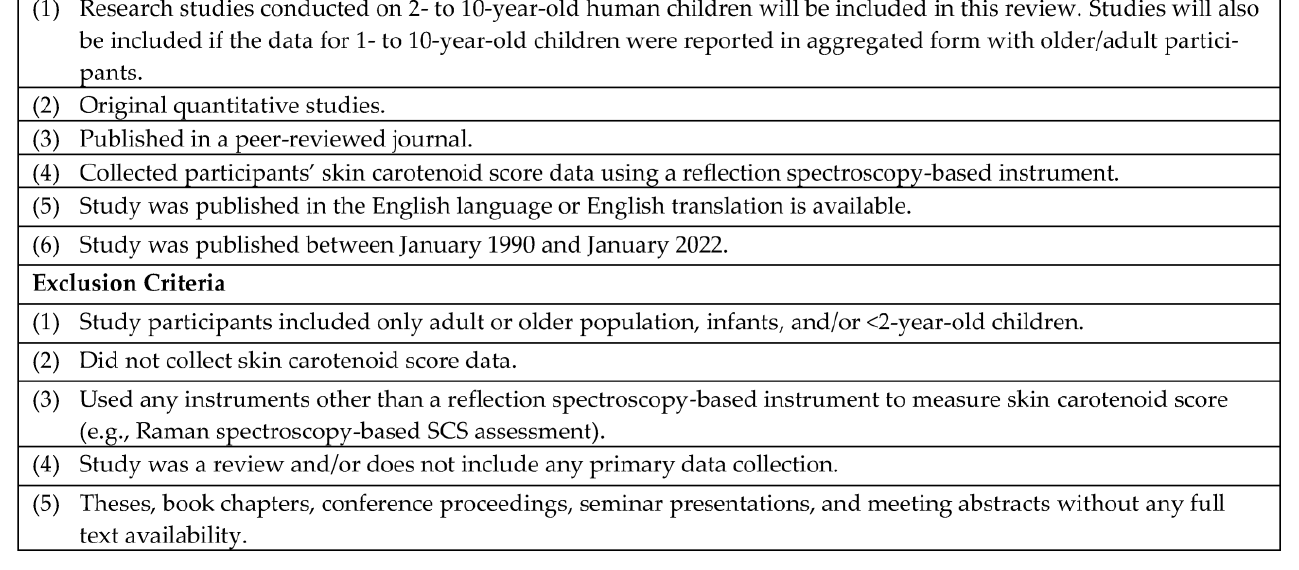
Figure 1. Inclusion and Exclusion Criteria for Selection of Studies.